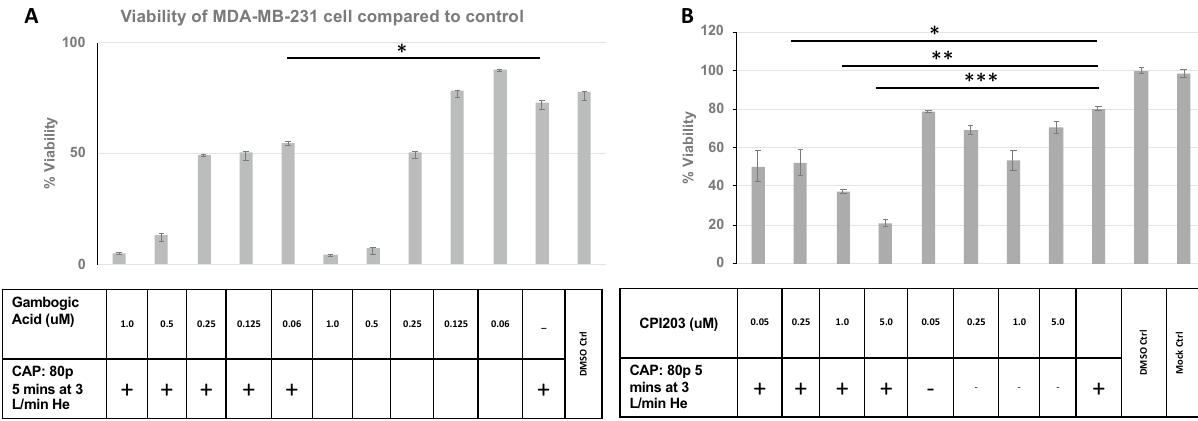
Figure 9. Combination of the BET bromodomain inhibitor CPI203 and CHCP treatment increases TNBC cell death. Viability of TNBC cell line MDA-MB-231 with Gambogic acid, an antagonist of antiapoptotic Bcl-2 family ( A ) or CPI203, a BET bromodomain inhibitor after CAP treatment. Bar graph represents MDA-MB-231 MTT cell viability assay after treatment with Gambogic acid ( A ) or CPI203 in the combination of with/without CAP treatment at 80p 5 min at 3 L/min He. The samples were compared to the mock control groups. The data is represented by the SEM (n = 3). (*p < 0.05, **p < 0.01, ***p < 0.001, Student’s